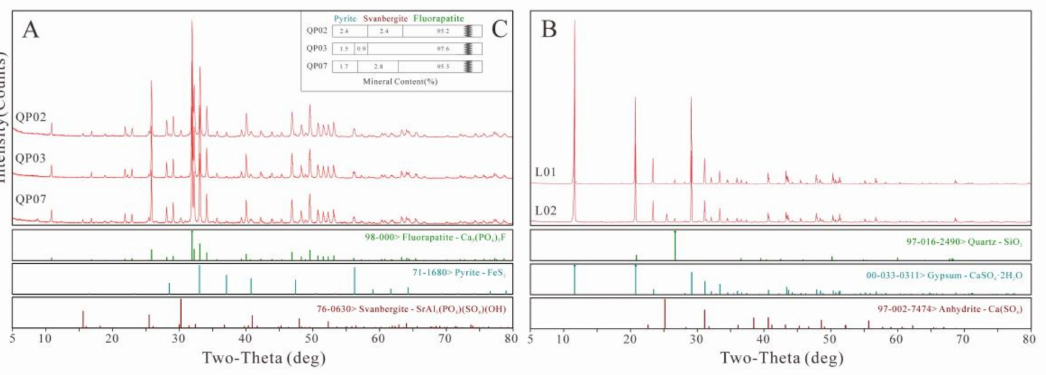
Figure 2. The X-ray diffraction patterns of phosphate rock ( A ) and phosphogypsum ( B ). The mineral content of phosphate rock is shown in ( C